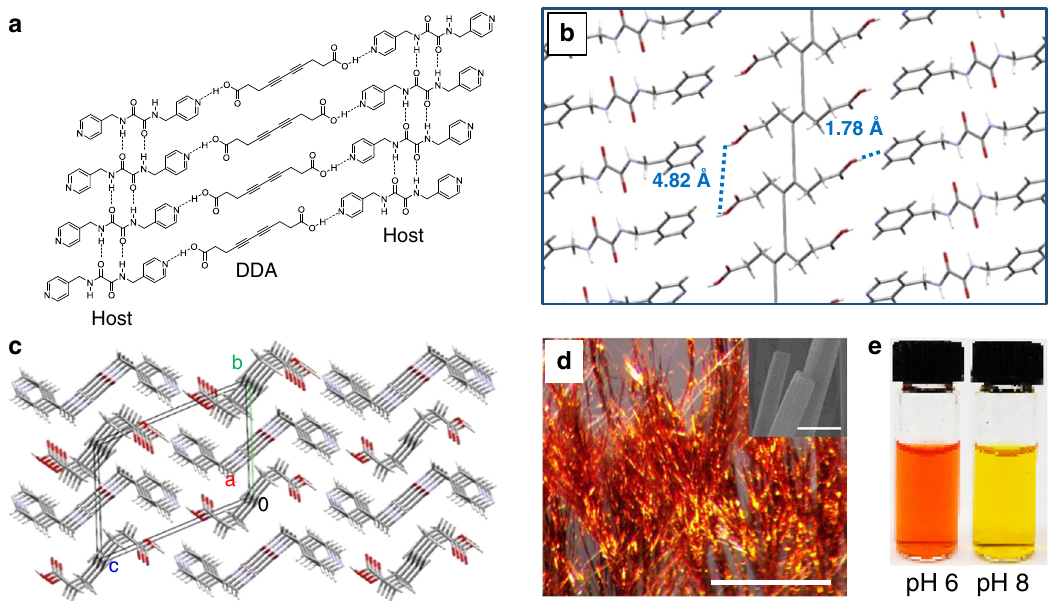
Fig. 2 Topochemical polymerization within single crystals for the synthesis of PDDA. a Ordered alignment of DDA monomers generated within a host – guest supramolecular framework with Host 1 . b , c Co-crystal structure of PDDA and host 1 , as determined by single crystal X-ray diffraction. b Side view; c Top view. The unit cell parameters (triclinic P-1) are a = 4.824(7) Å, b = 9.085(12) Å, c = 12.724 Å, α = 108.78(3)°, β = 96.71(3)°, γ = 96.19(3)°, V = 518.03 Å3, Z = 2. d Microscope image of PDDA· 1 co-crystals. Scale bar: 1 mm. Inset: Scanning electronic microscopy image of the corresponding co- crystals. Scale bar: 2 μ m. e PDDA aqueous solution at different pH